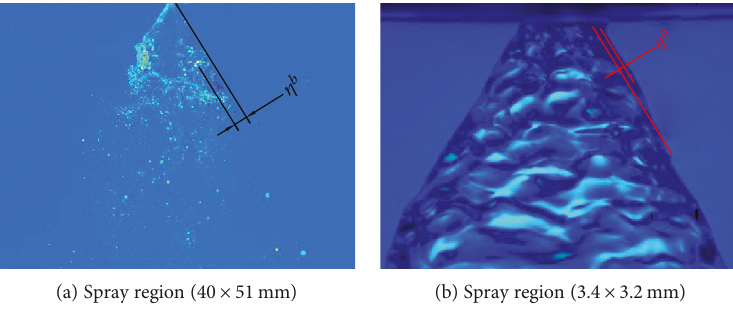
Figure 12: Schematic of the amplitude of the disturbance on the liquid